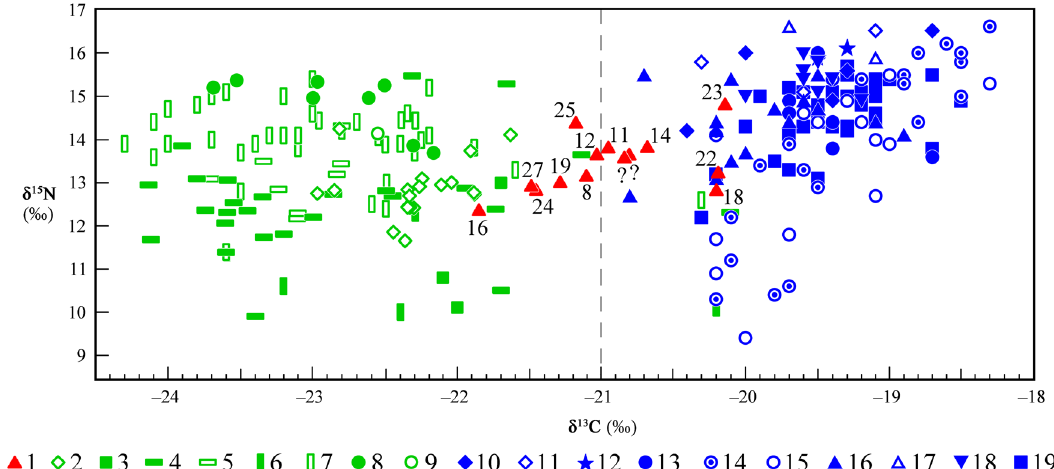
Figure 7: Scatterplot of δ 15 N and δ 13 C isotope values of human bones from: 1 – Vasylivka II cemetery ( according to data from Lillie and Jacobs, 2006, p. 881, Table 1 ) ; 2 – 9 – Mesolithic ( 2, 3 ) and subNeolithic ( 4 – 9 ) cemeteries in the Dnipro region